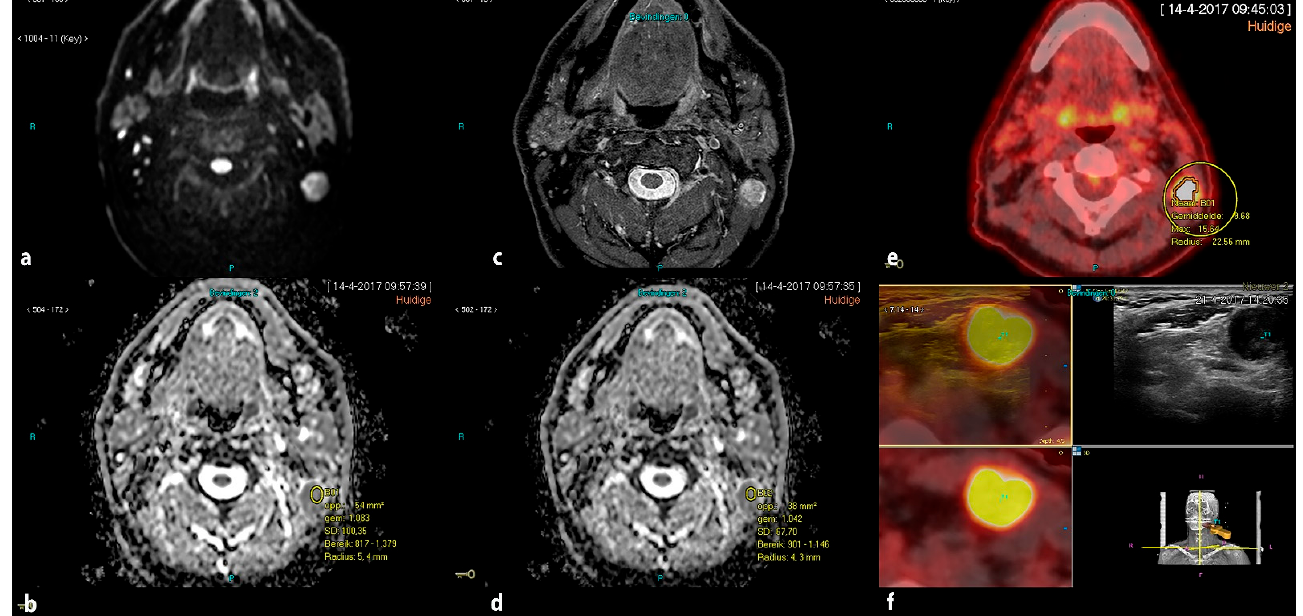
Figure 1. Drawing manual ROI in ADCb 0-1000 and ADC b0-200-1000 in a PET-positive lymph node. ( a ) DWI acquired by b-0-200-1000 s/mm 2 ; ( b ) ROI in ADC b0-1000 ; ( c ) axial STIR; ( d ) ROI in ADC b0-200-1000 ; ( e ) corresponding PET-positive node; ( f ) corresponding real-time image-fused guided FNAC of the PET-positive node .